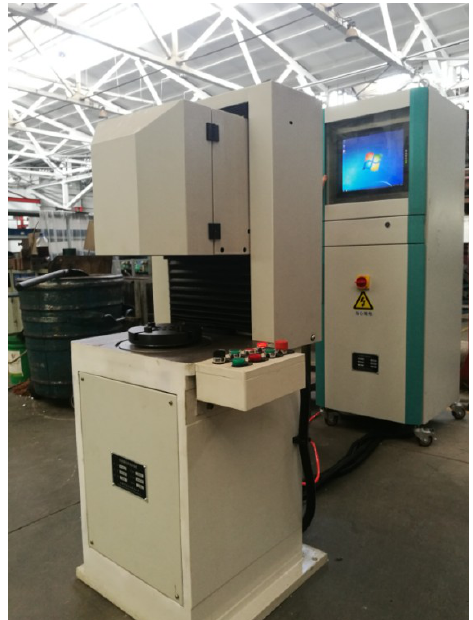
Figure 9. Schematic diagram of the synchronizer detection device.